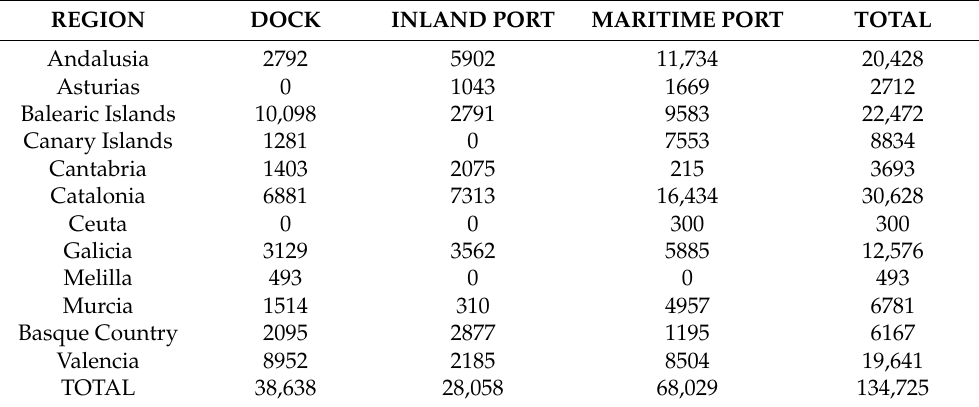
Table 1. Spanish nautical facilities by type and region.